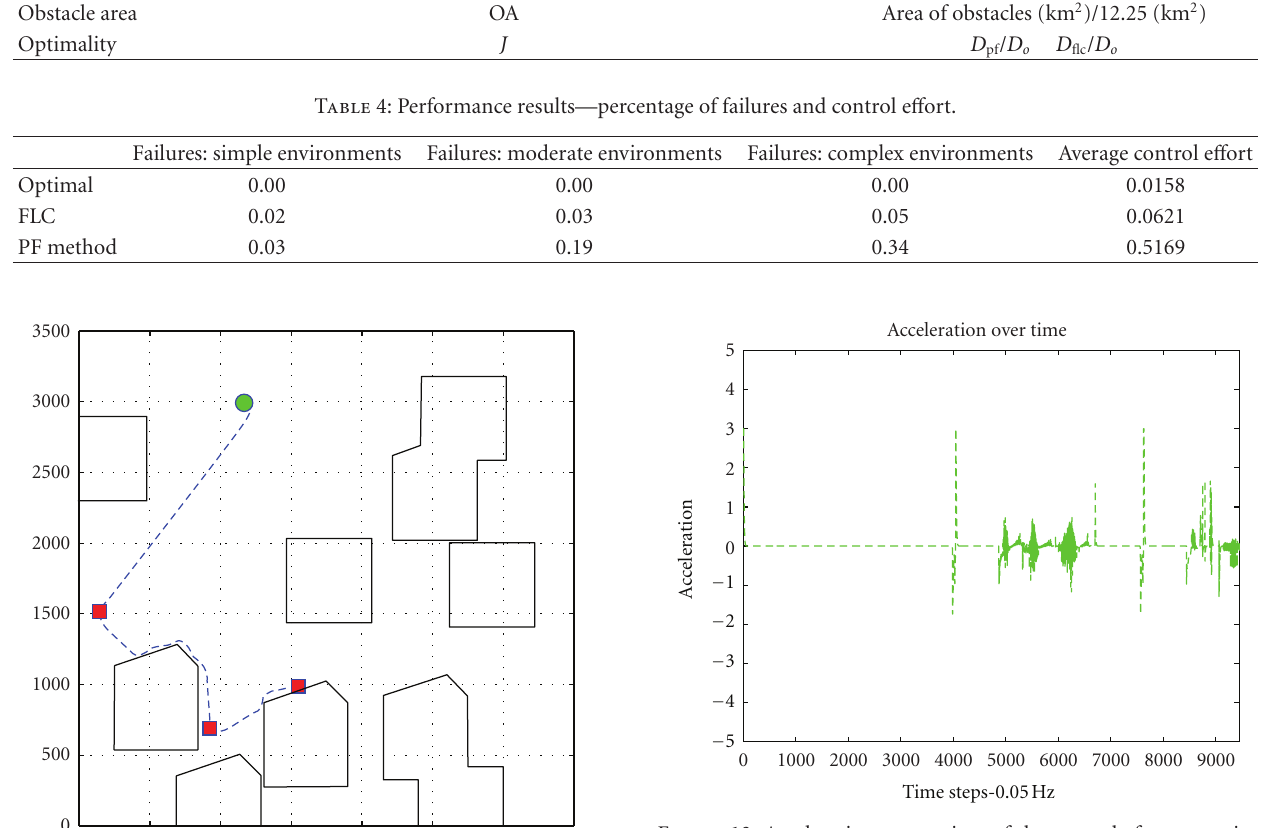
Figure 13: Acceleration versus time of the example for constraint verification.